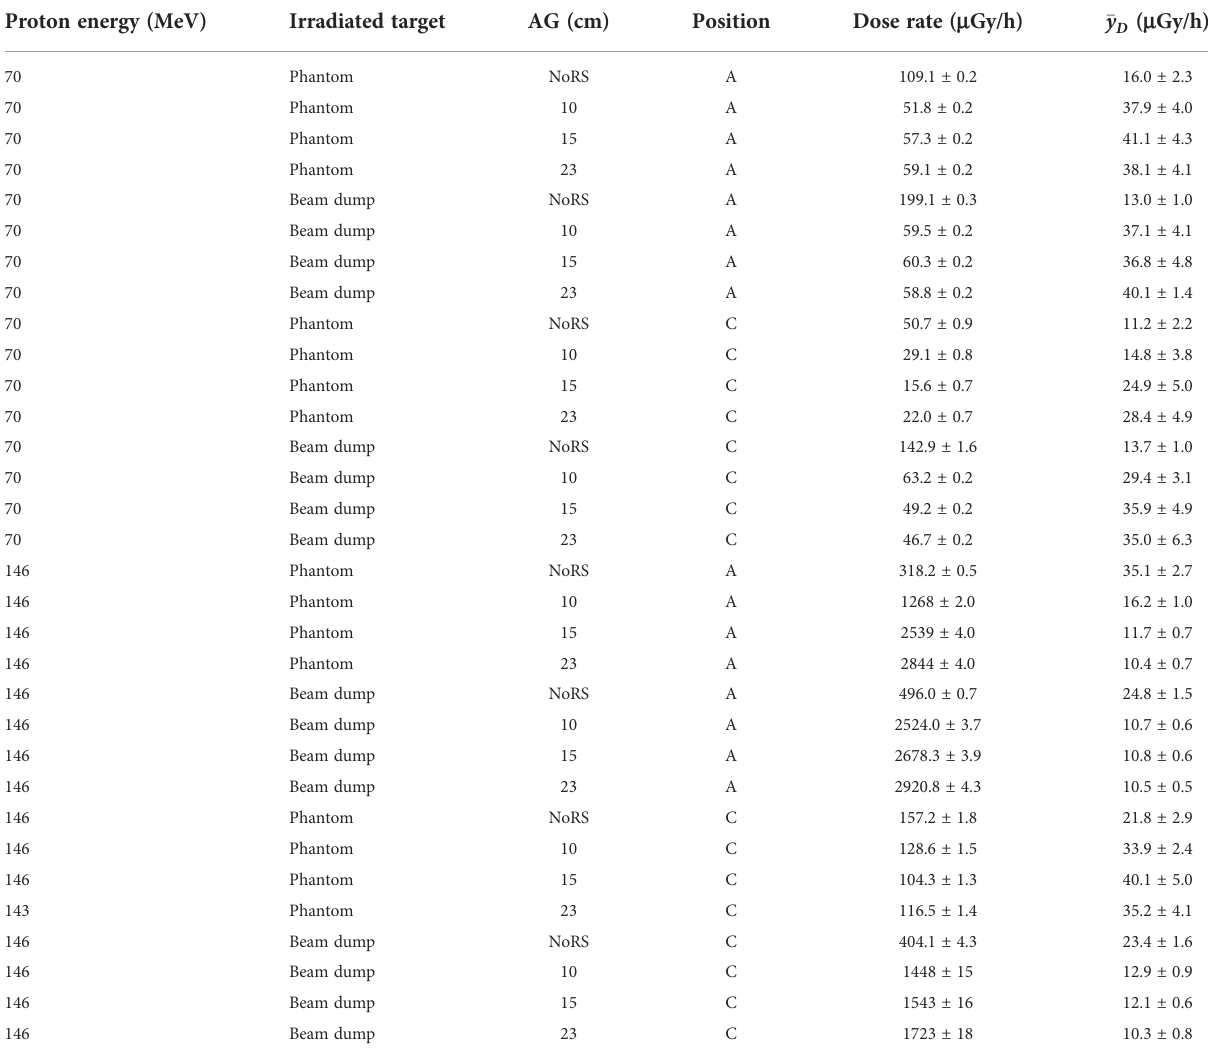
TABLE 1 Measured absorbed dose rates and (cid:1) y D values for different irradiation settings. Proton energy